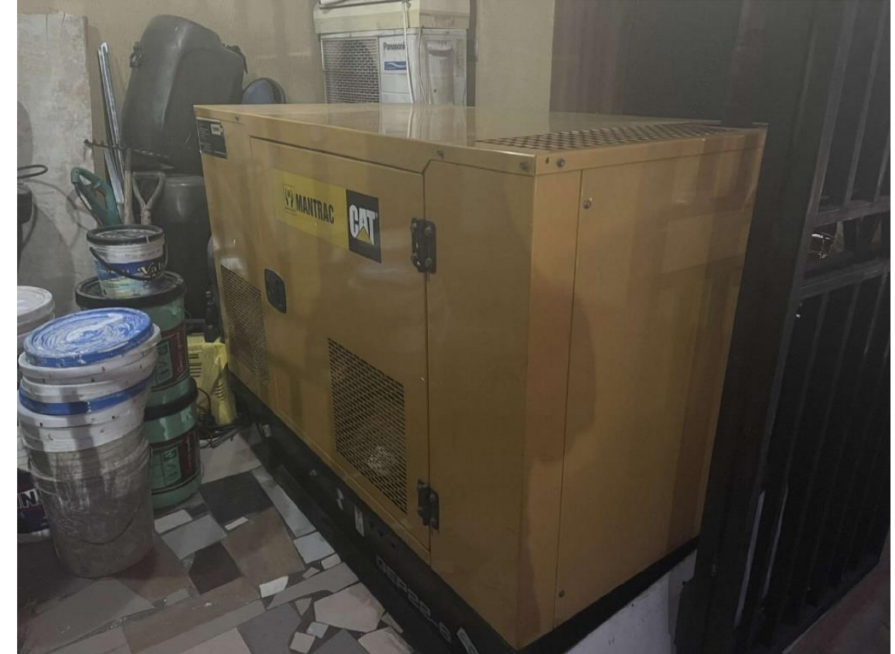
Figure 5. Power generating set in a home—Lagos, Nigeria. Source: [41]. Generators range from 0.5 kVA (0.4 kW) for a small business kiosk to large generators of 75 kVA (60 kW), which service residential estates and industries [42]. A 2014 World